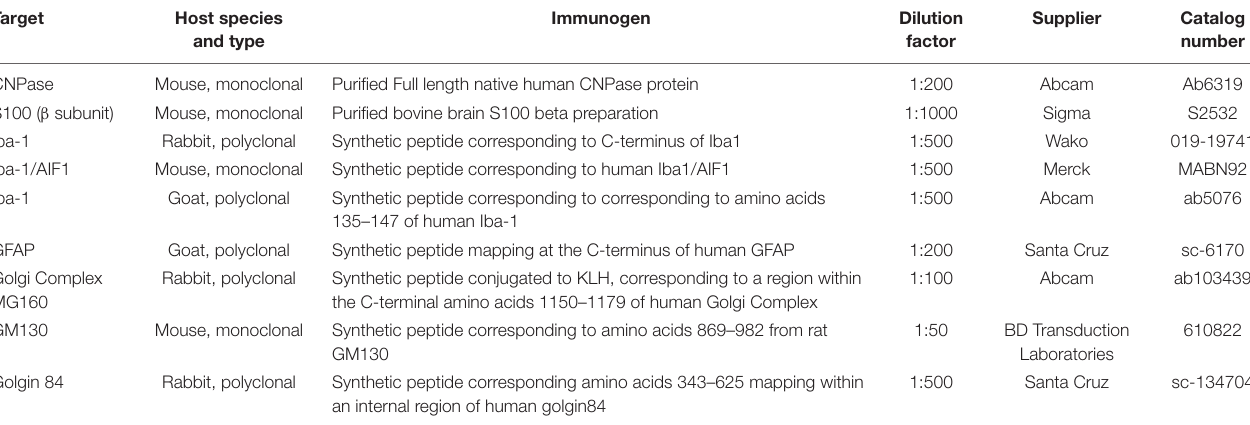
TABLE 1 | Summary of primary antibodies and combinations used for immunodetection.